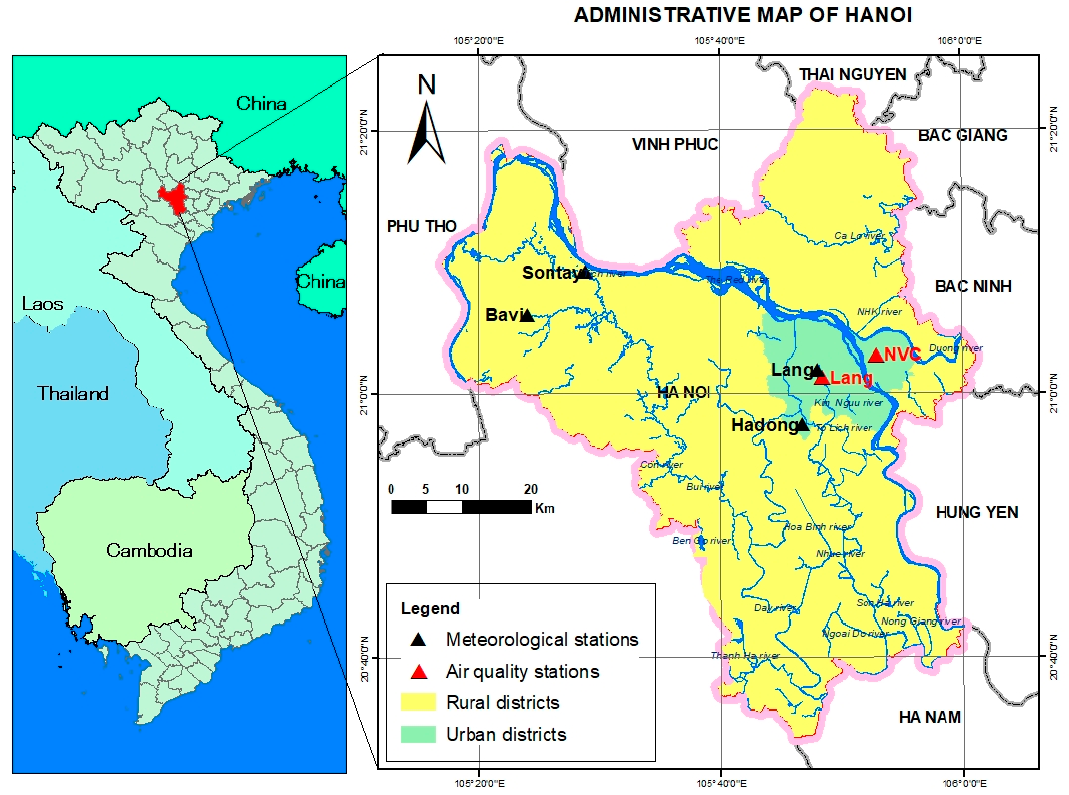
Figure 1. ( Left ) Map of Vietnam and neighboring countries. ( Right ) Administrative map of Hanoi and its districts (colored parts). Two air quality stations (red triangles) and four meteorological stations (black triangles) are shown. The areas in green represent urban districts which are in the center of Hanoi. The areas in yellow represent rural districts.